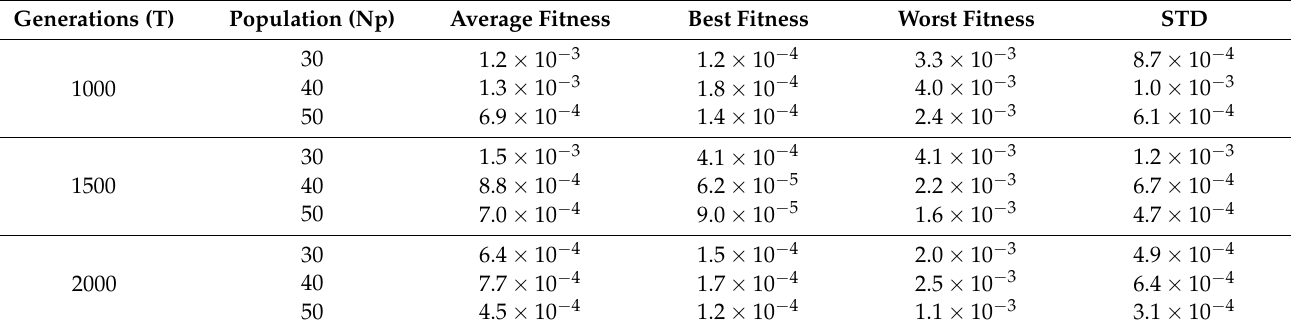
Table 7. AO parameter analysis for case 6.